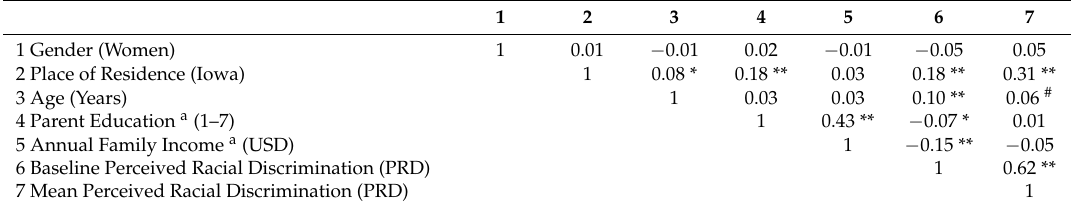
Table 2. Correlation matrix of the study variables ( n =